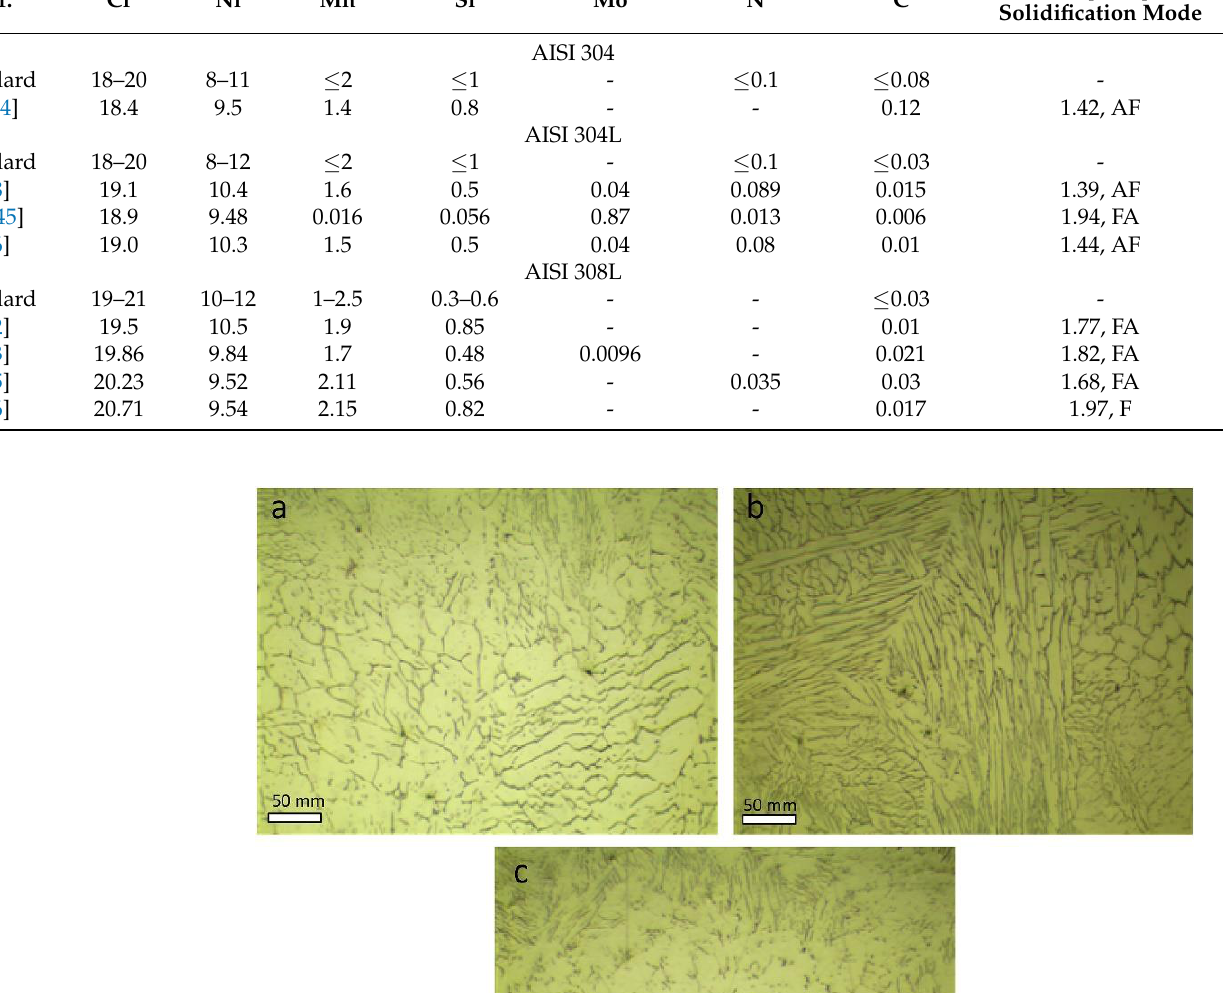
Table 1. Chemical compositions (wt.%, Fe balanced) and corresponding values of Cr eq /Ni eq ratio for AISI 304 and 308 type austenitic stainless steels used for AM. AF—austenite-ferrite solidification mode, FA—ferrite-austenite solidification mode, F—ferrite solidification mode. Data are adapted from [8,12,16,18,22,25,43–46]. Ref.